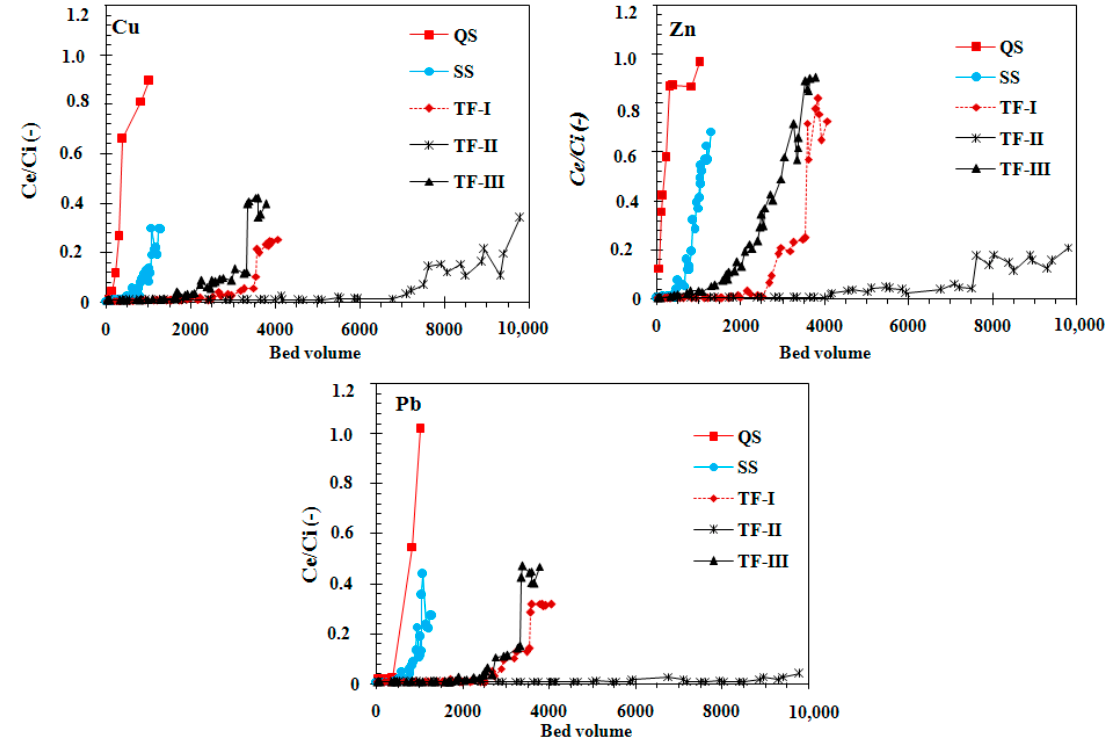
Figure 5. Breakthrough curves of column experiments for metal mixtures. The lines are not fitting functions; they simply connect points to facilitate visualization.